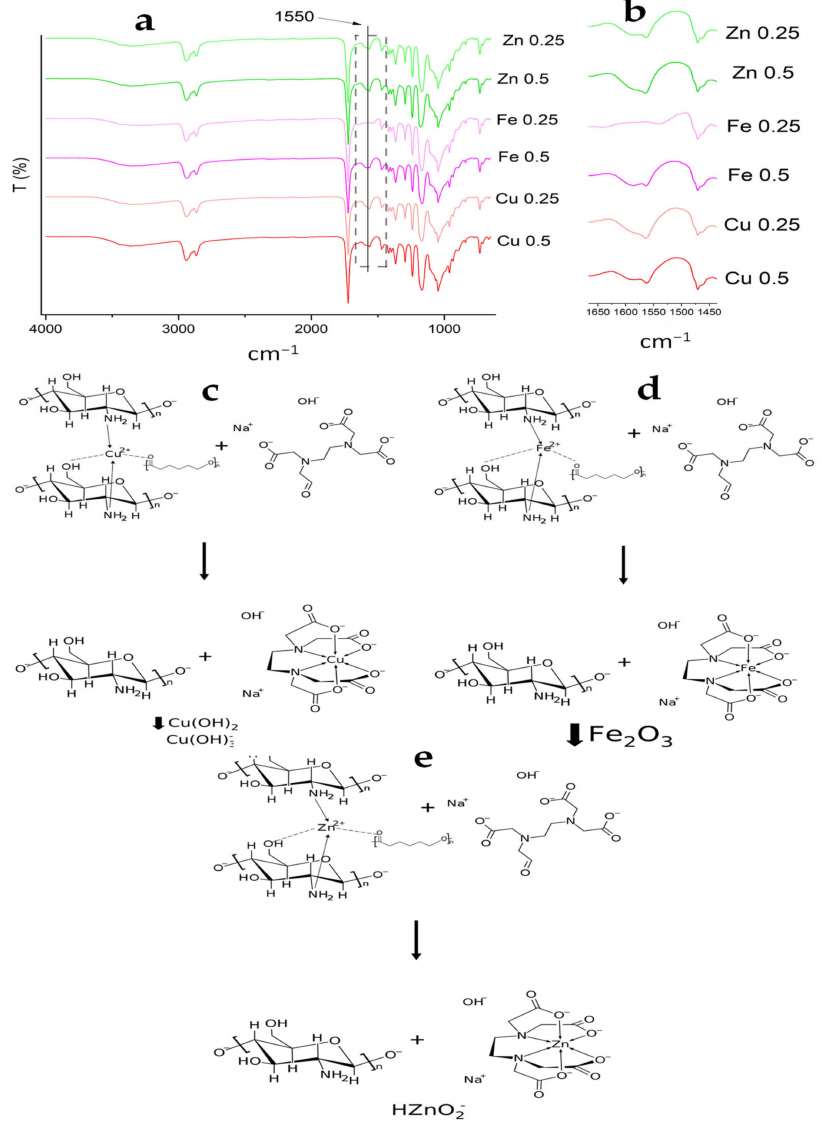
Figure 8. FTIR spectra of MCPA after desorption treatment with an EDTA solution and 0.25 or 0.5 N of NaOH ( a ); 1650–1400 cm − 1 region ( b ); proposed desorption mechanism for Cu(II) ( c ); Fe(II) ( d ) and Zn(II) ( e